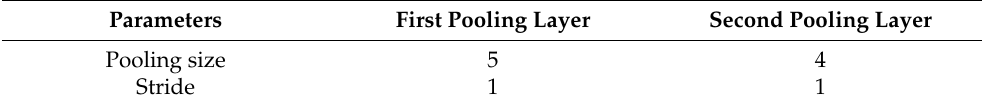
Table 6. Pooling Layer.